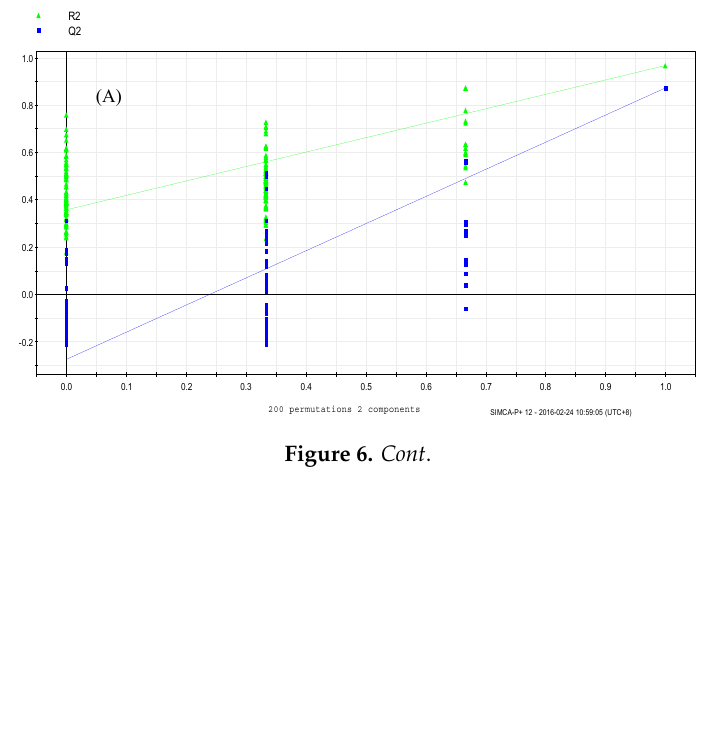
Figure 5. PLS-DA score plot of RAW264.7 cells from treatment and control groups. ( A ) LPS and control groups ( B ) SPPM60-D and control groups.